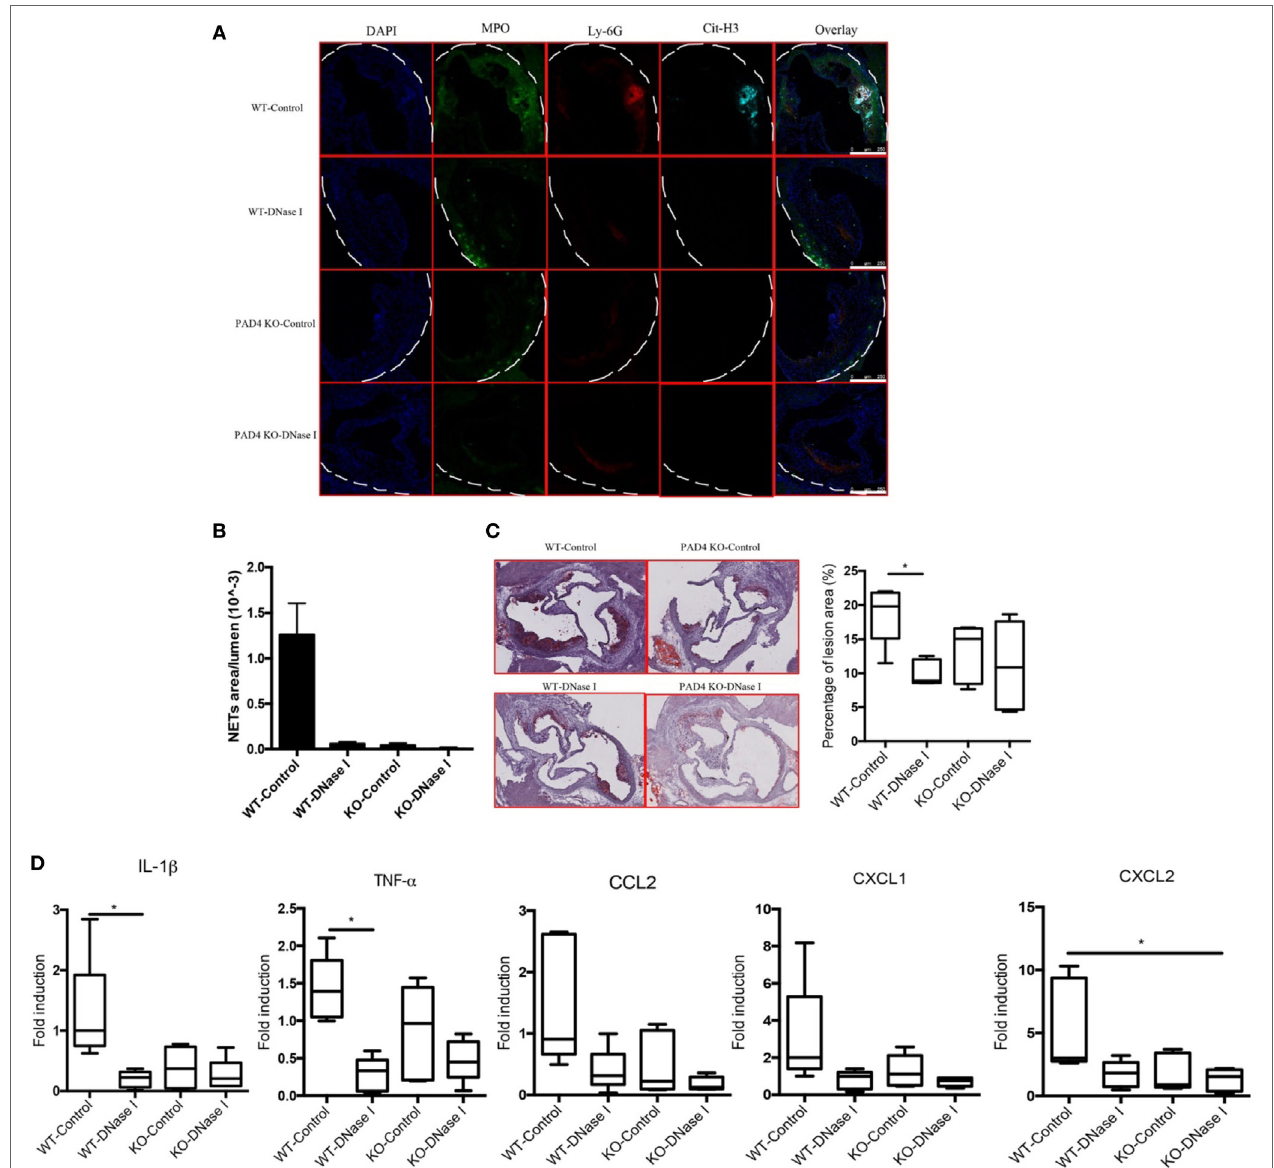
FigUre 7 | Deoxyribonuclease (DNase) I treatment abolished neutrophil extracellular traps (NETs) formation and ameliorated atherosclerotic burden. WT and peptidylarginine deiminase 4 (PAD4) KO mice were fed on high-fat chow (HFC) for 6 weeks, starting at 3-week HFC, 400 U of DNase I or vehicle control (PBS) was intravenously administered three times weekly until the end of experiments. (a) Representative confocal immunofluorescence microscopy images of aortic root sections stained for DAPI (blue), MPO (green), Ly-6G (red), and Cit-H3 (cyan). Data are representative of five mice in each group. (B) Quantification of NETs from (a) ( n = 5/group). (c) Representative images of aortic root sections stained for lipid (Oil Red O, red) and hematoxylin ( n = 5/group). (D) mRNA levels of IL-1 β , TNF- α , CCL2, CXCL1, and CXCL2 in the aorta from WT and PAD4 KO mice placed on HFC for 6 weeks and administered with DNase I or vehicle control (PBS). mRNA levels were normalized to the GAPDH and expressed relative to levels measured in one of the vehicle control-treated WT mice ( n = 5/group). * p <